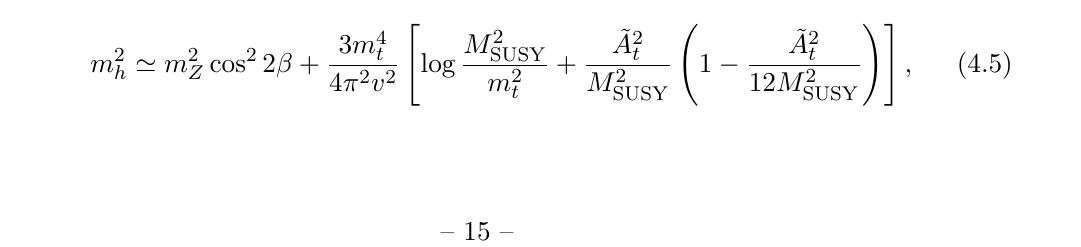
JHEP05(2019)009